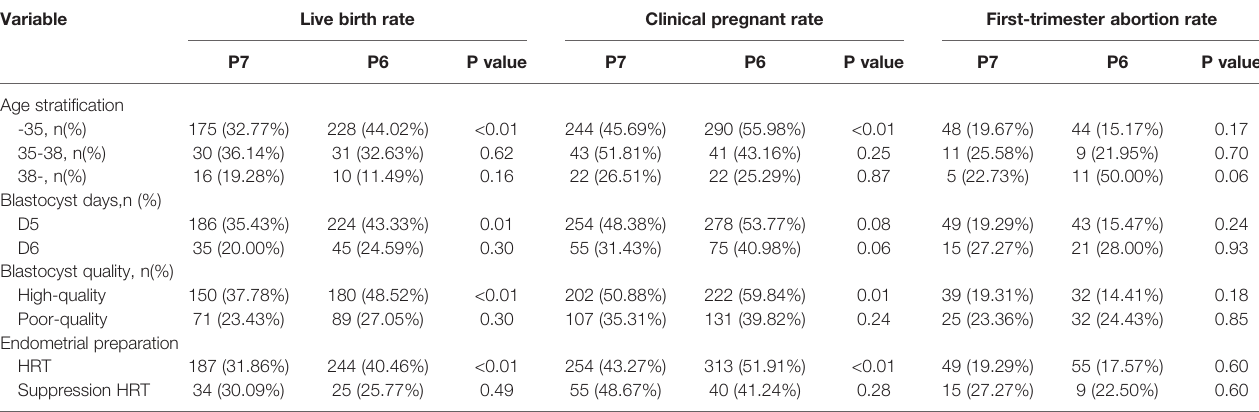
TABLE 3 | Clinical outcomes of subgroups in PS-matched population.